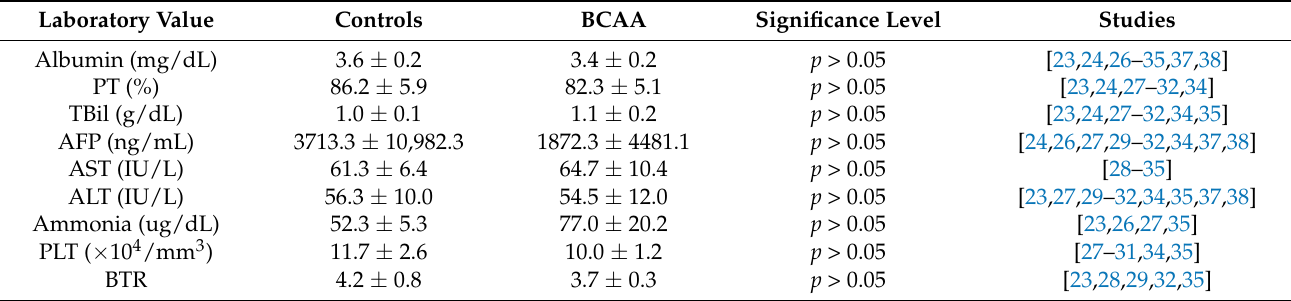
Table 2. Baseline laboratory characteristics.